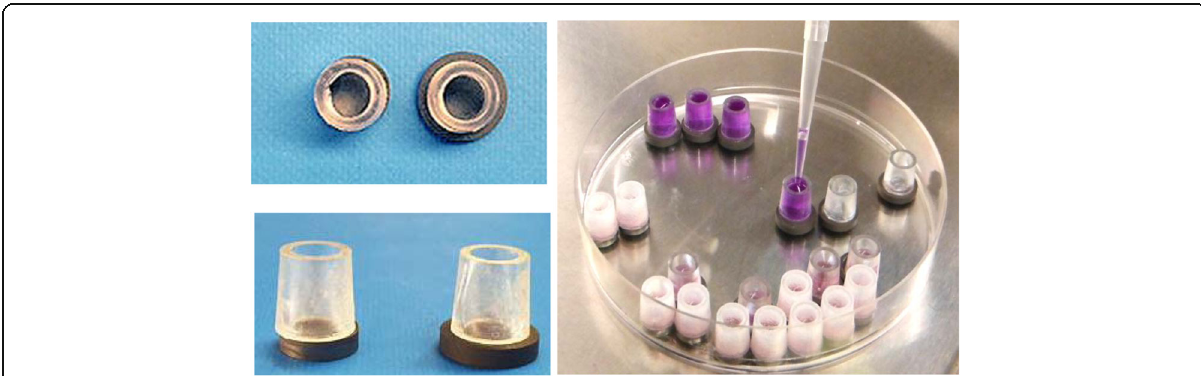
Fig. 1 Preparation of specimens. Small disks represent 3M ™ ESPE ™ MDI implants, and large disks represent Ankylos® implants. Note that the attachment of polystyrene rings ensures the area of culture remains constant regardless of the disk